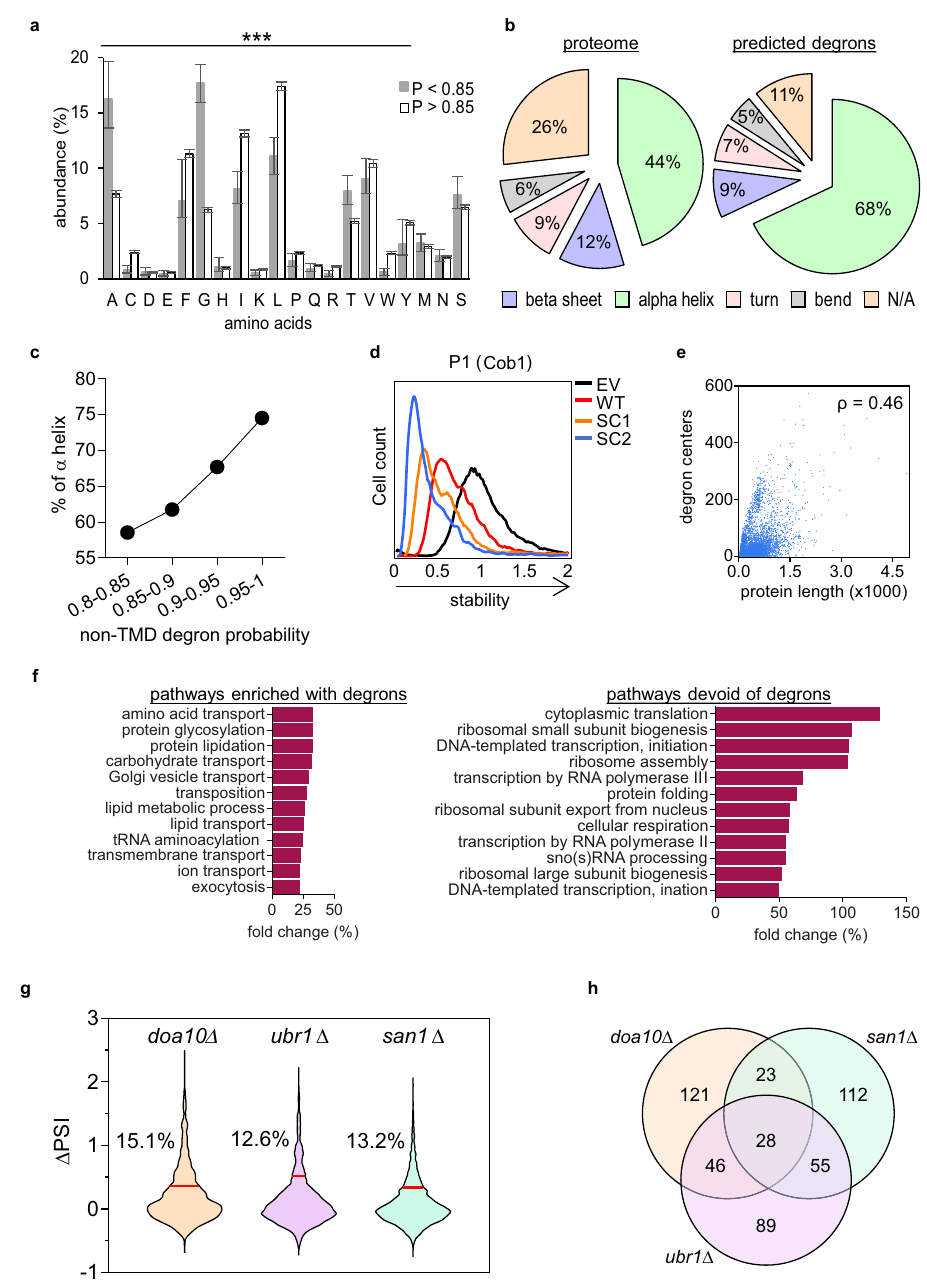
Fig. 5 | Characterization of QCAP degrons. a Comparison of mean amino acid distribution between TMDs in the yeast proteome with high degron probability (P ≥ 0.85; White color; n = 1204) to those with lower probability ( P <0.85; Gray color; n = 107). Data are presented as mean values+/- low and high con fi dence intervals.Statisticaltestswere( a )Chi-square ( p = 0.018;DF= 19) thatwasfollowed by ( b ) Two sided Mann Whitney U test (***: p <0.001). Amino acid residues serine, methionine and asparagine did not show signi fi cant differences between the two groups. b Pie chart of the classi fi cation and relative proportions of protein sec- ondarystructureversusthatofQCDPred-predicteddegronswithintheentireyeast proteome, based on the AlphaFold Protein Structure Database. c Plot of the per- centile of α helix structures versus QCDPred assigned non-TMD degron prob- abilities, divided into four equal bins. d Flow cytometry histograms of the normalized yeG/yeC ratio in cells expressing P1 peptide emerged from the yeast protein Cob1 and two randomly scrambled variants SC1 and SC2. Stability scale: Median value of the yeG/yeC ratio in empty vector (EV) control was set as one.